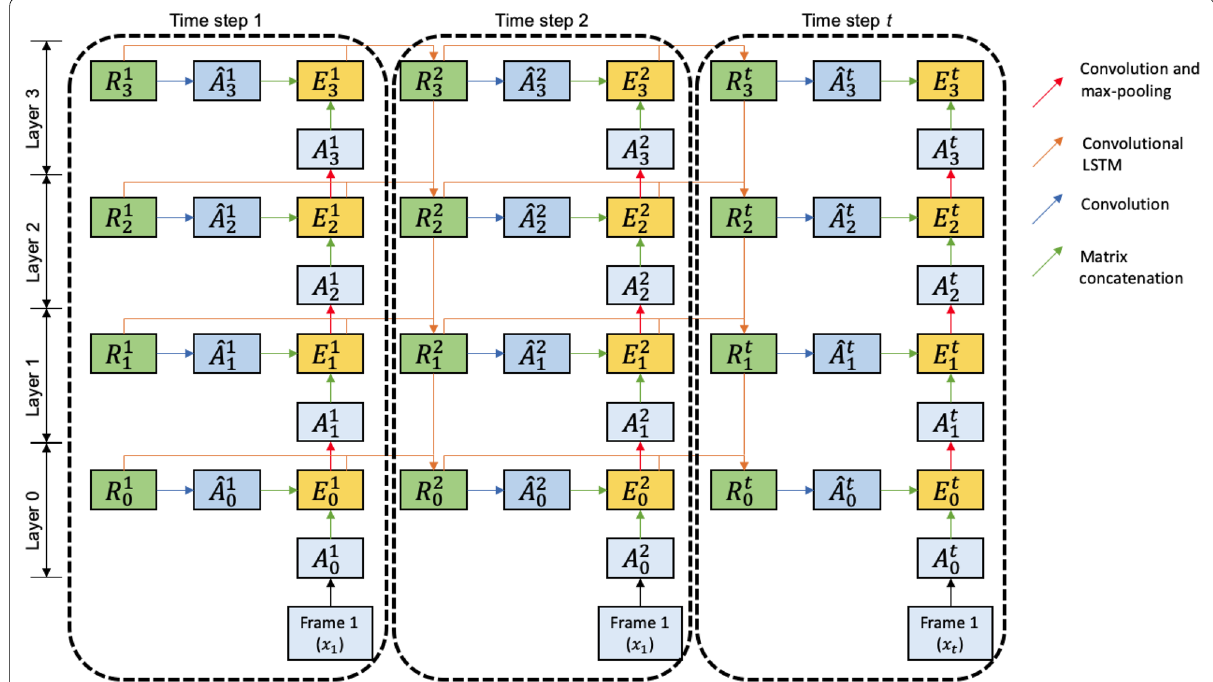
Fig. 1 Architecture of the deep predictive coding